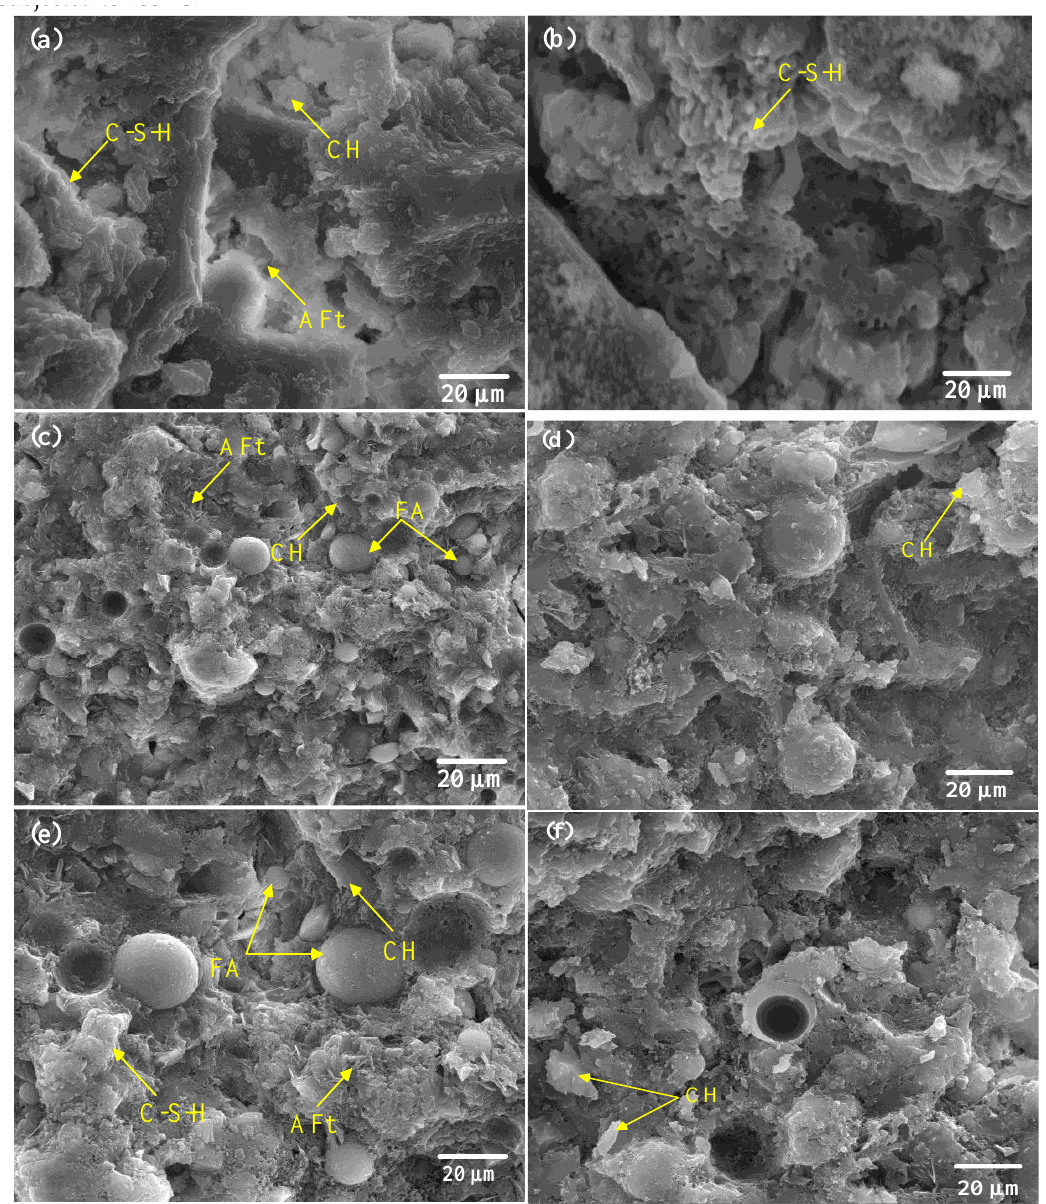
Figure 8. The microstructure alteration of concrete after heating: ( a ) and ( b ) refer to the reference concrete subjected to room temperature (RT) and 400 °C, respectively; ( c ) and ( d ) refer to HPC-2 subjected to RT and 400 °C, respectively; ( e ) and ( f ) refer to HPC-4 subjected to RT and 400 °C, respectively.